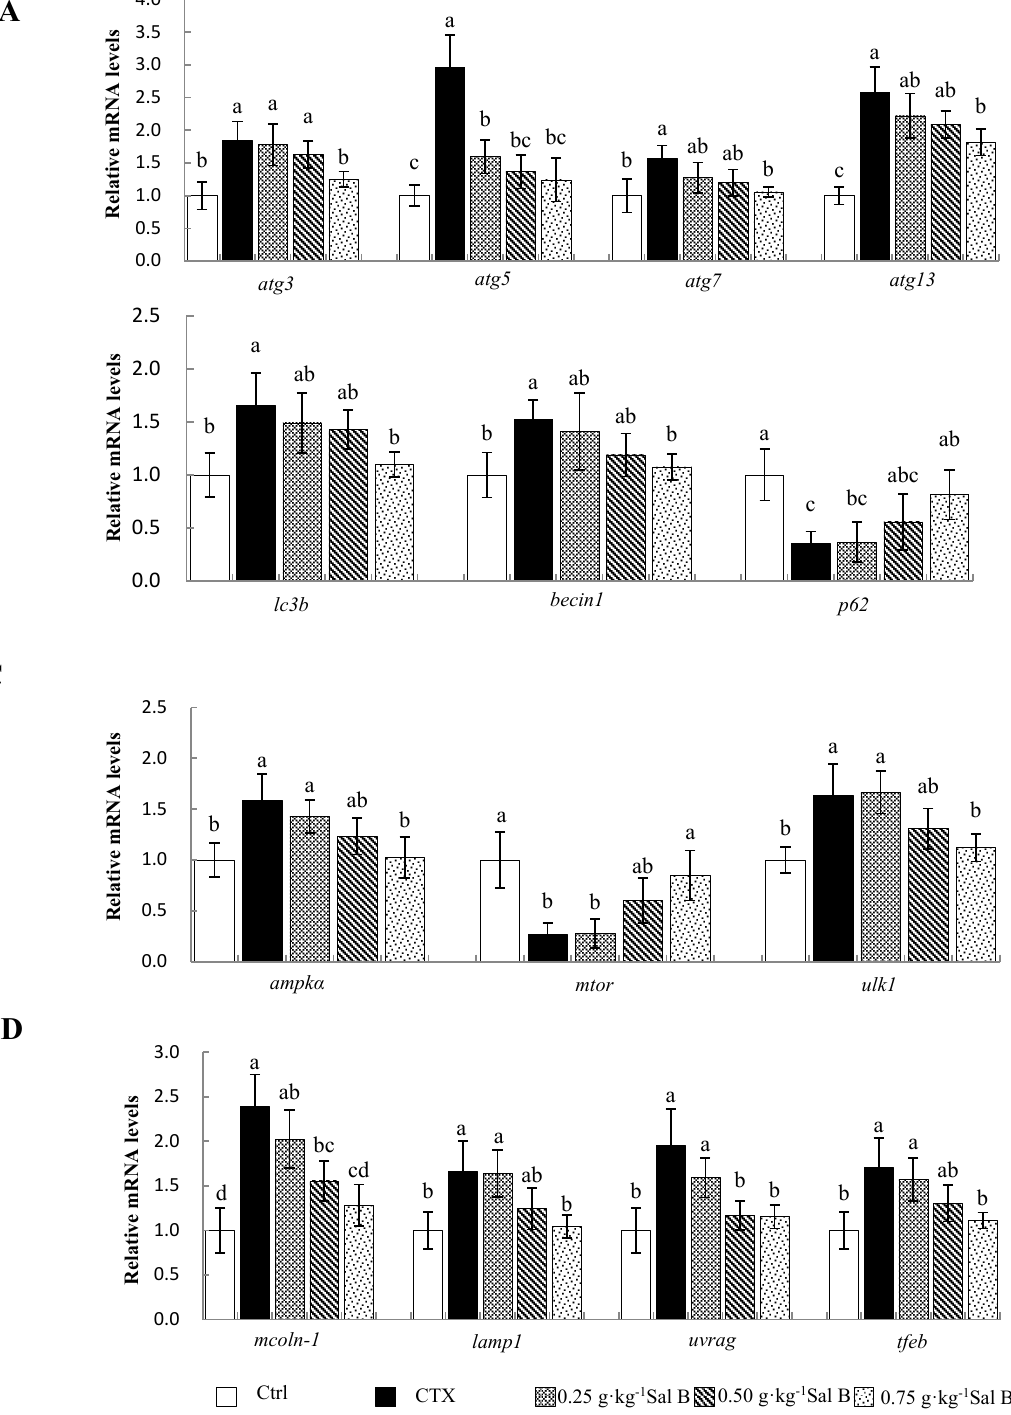
Figure 4. Effects of Sal B on autophagy and AMPK/mTOR-pathway-related gene mRNA levels in liver samples of Nile tilapia: ( A , B ) expression of autophagy-related genes; ( C , D ) expression of AMPK/mTOR-pathway-related genes. The values are means ± SE ( n = 8). a,b,c Different superscript letters for each parameter indicate significant differences ( p < 0.05).